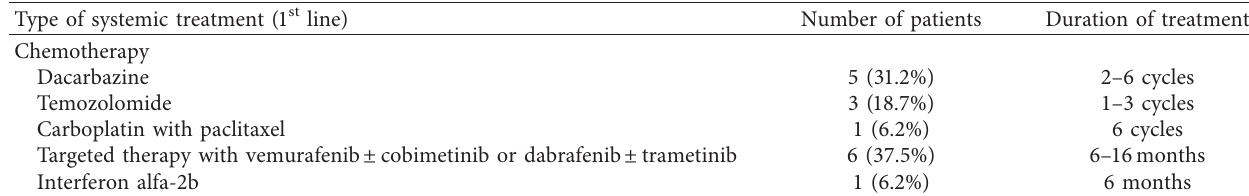
Table 2: Systemic treatment after diagnosis of brain metastases.